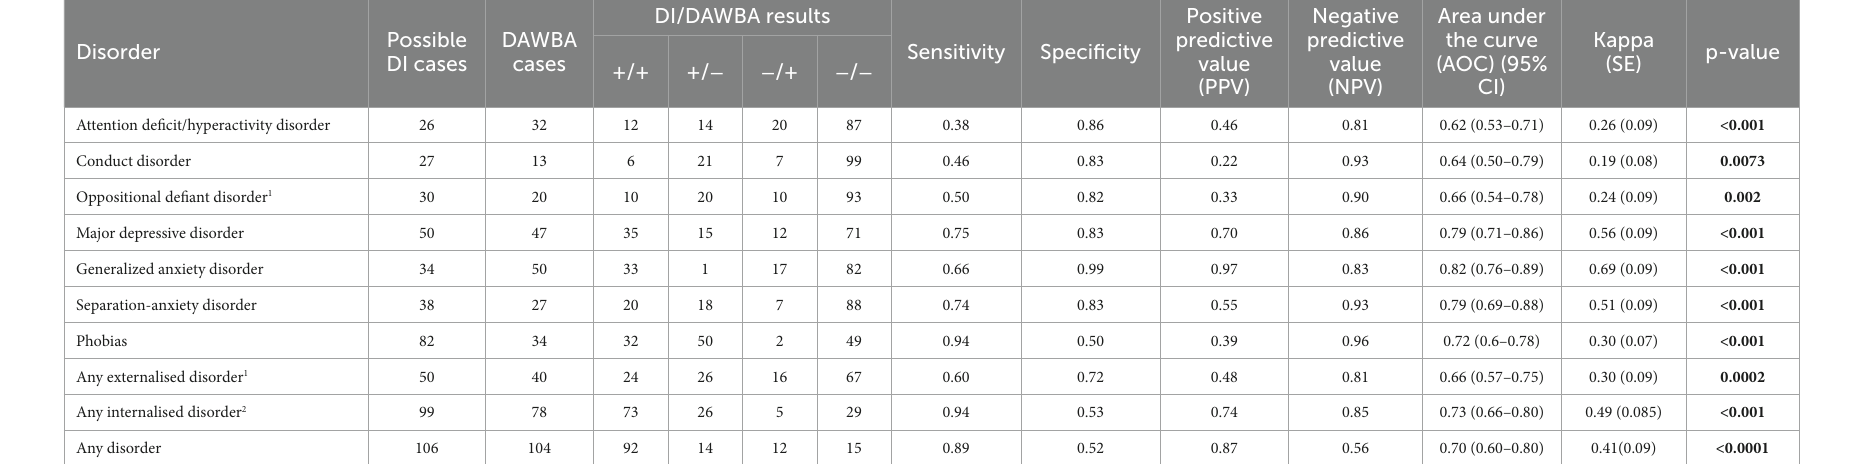
TABLE 2 Comparison of the diagnostic results of the self-report Dominic Interactive (DI) video game [possible cases (including probable cases)] to that of the diagnostic result of the clinician-administered Development and Well- Being Assessment (DAWBA) in 133 children in Tianjin,